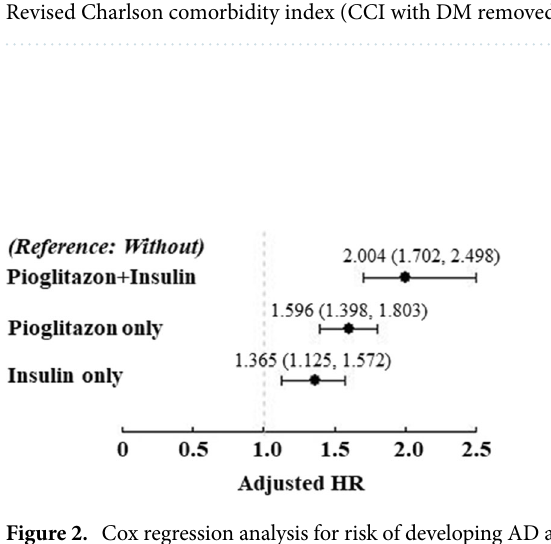
Table 2. Cox-regression analysis of factors associated with Alzheimer’s disease (n = 31,422). aHR, adjusted hazard ratio (Adjusted variables listed in the table); CI, confidence interval; DM, diabetes mellitus; CCI_R,